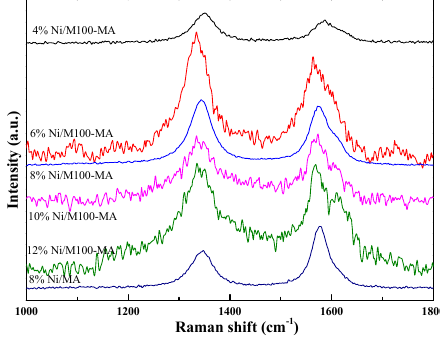
Figure 12. Raman spectra of the spent catalysts.